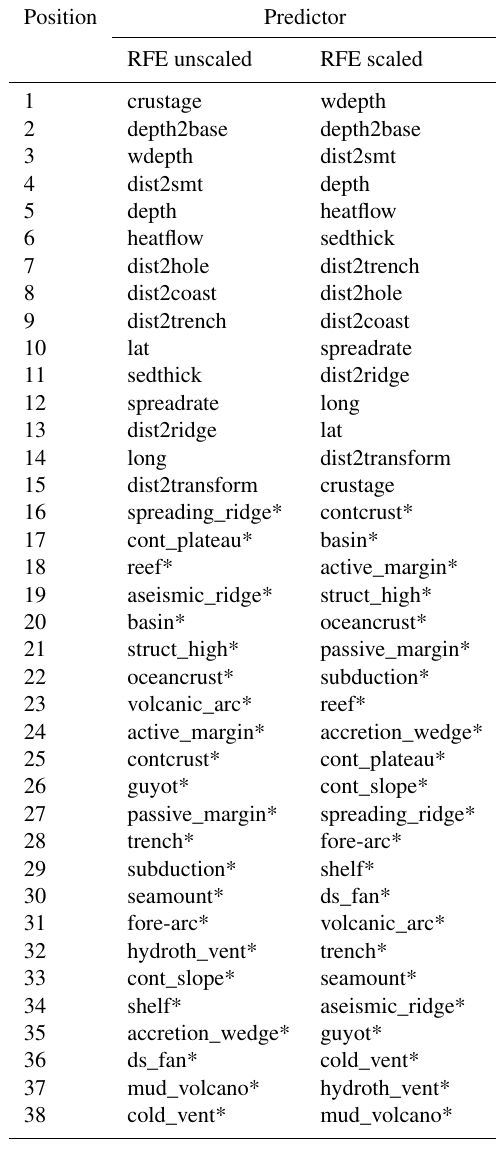
Table 3. Predictor ranking based on the RFE results for unscaled and scaled predictors. Categorical predictors are marked with an asterisk. See Table 1 for an explanation of predictor